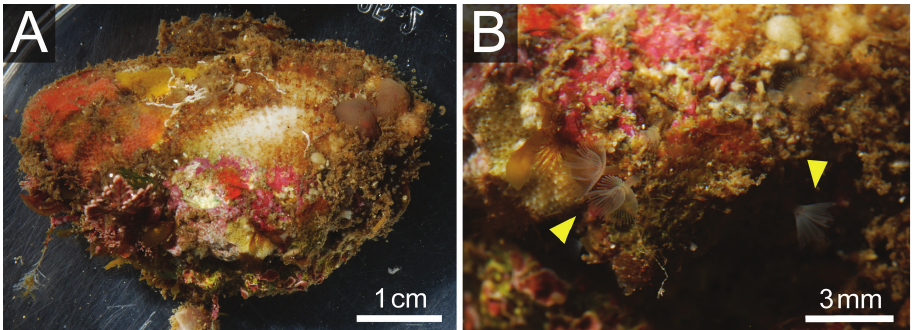
Figure 3. Phoronis ijimai Oka, 1897, NSMT-Te 880. A Living bivalve ( Barbatia sp.) with various sessile organisms B Living Phoronis ijimai on the shell